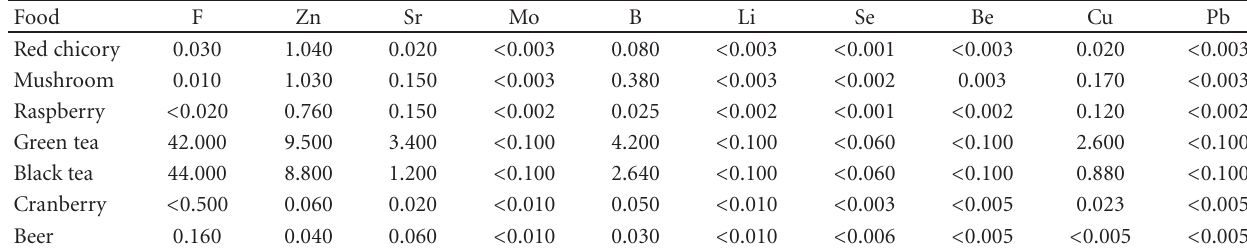
Table 5: Food/beverage mineral contents, expressed in